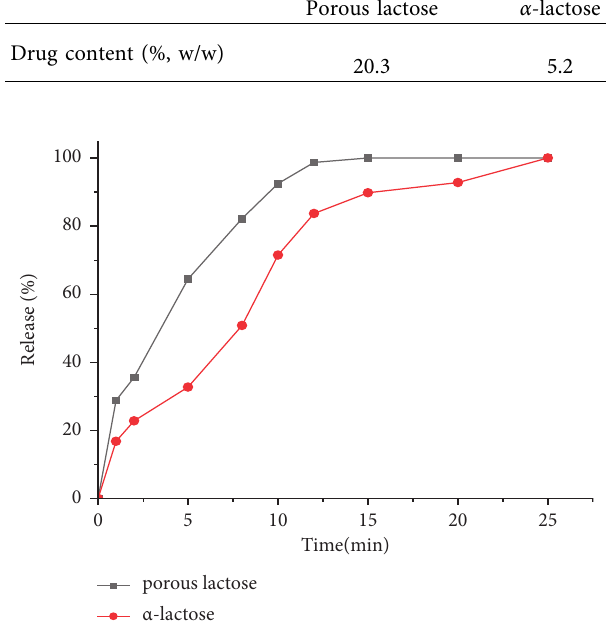
Figure 7: Release profiles of quercetin from the porous lactose- carried